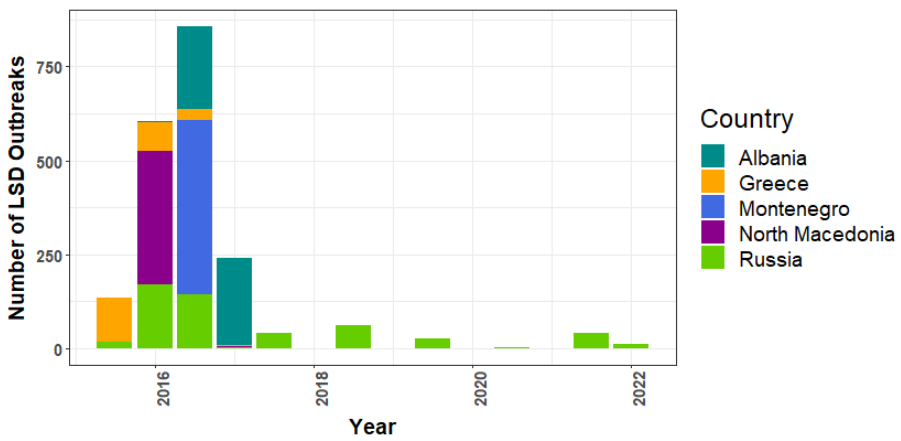
Figure 3 . Top five European nations with the most reports of lumpy skin disease outbreaks. In Asia (Figure 4), Oman had the highest number of reports ( n = 1938) during the whole study period, with the maximum in 2019. From 2013 to 2019, Turkey reported no- tably high numbers of LSD epidemics in 2014 and 2015. Iran had its highest number in 2019. During the period from 2021 to January 2022, Thailand had the highest number of LSD reports.